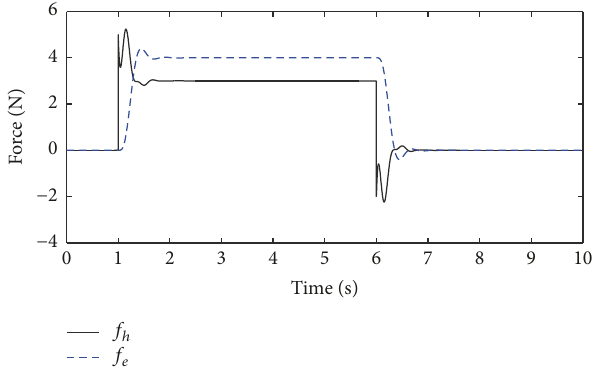
Figure 8: Force tracking performance when there are no delays in the communication channel.